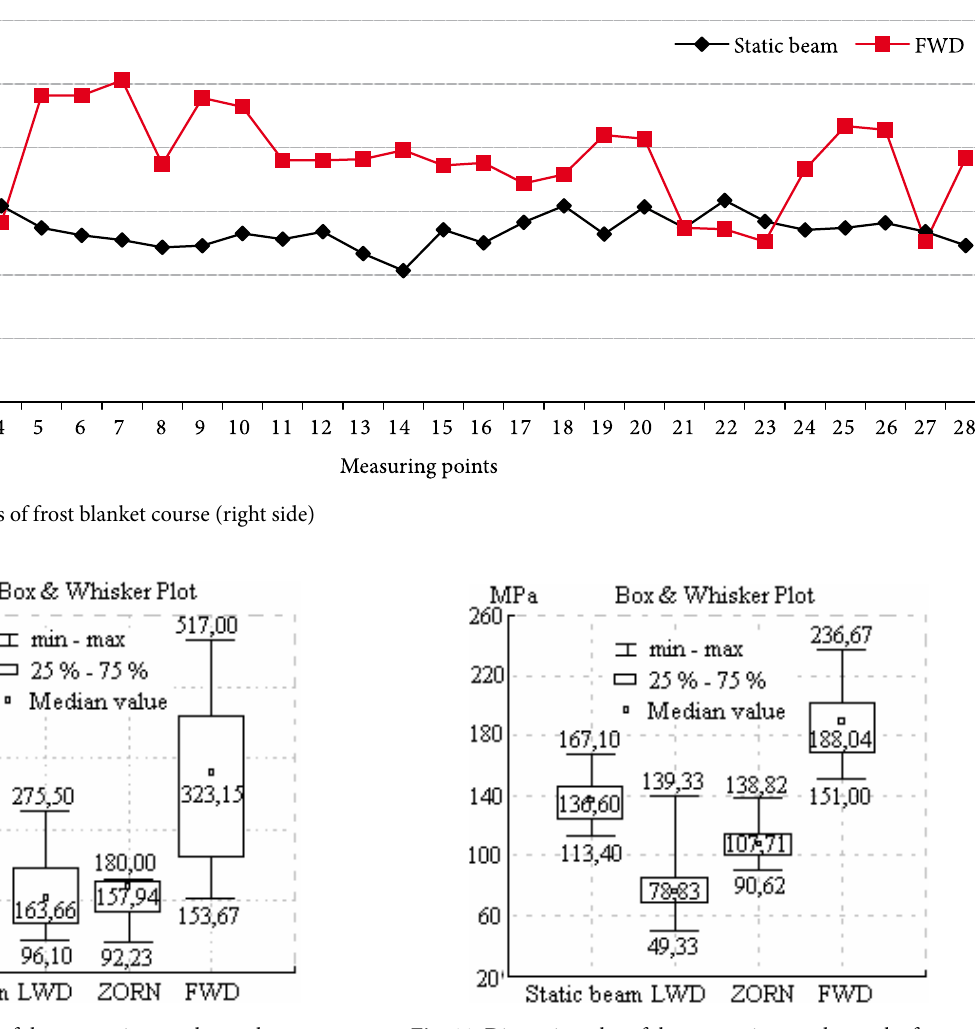
fig. 10. Dispersion plot of the measuring results on the subgrade (left